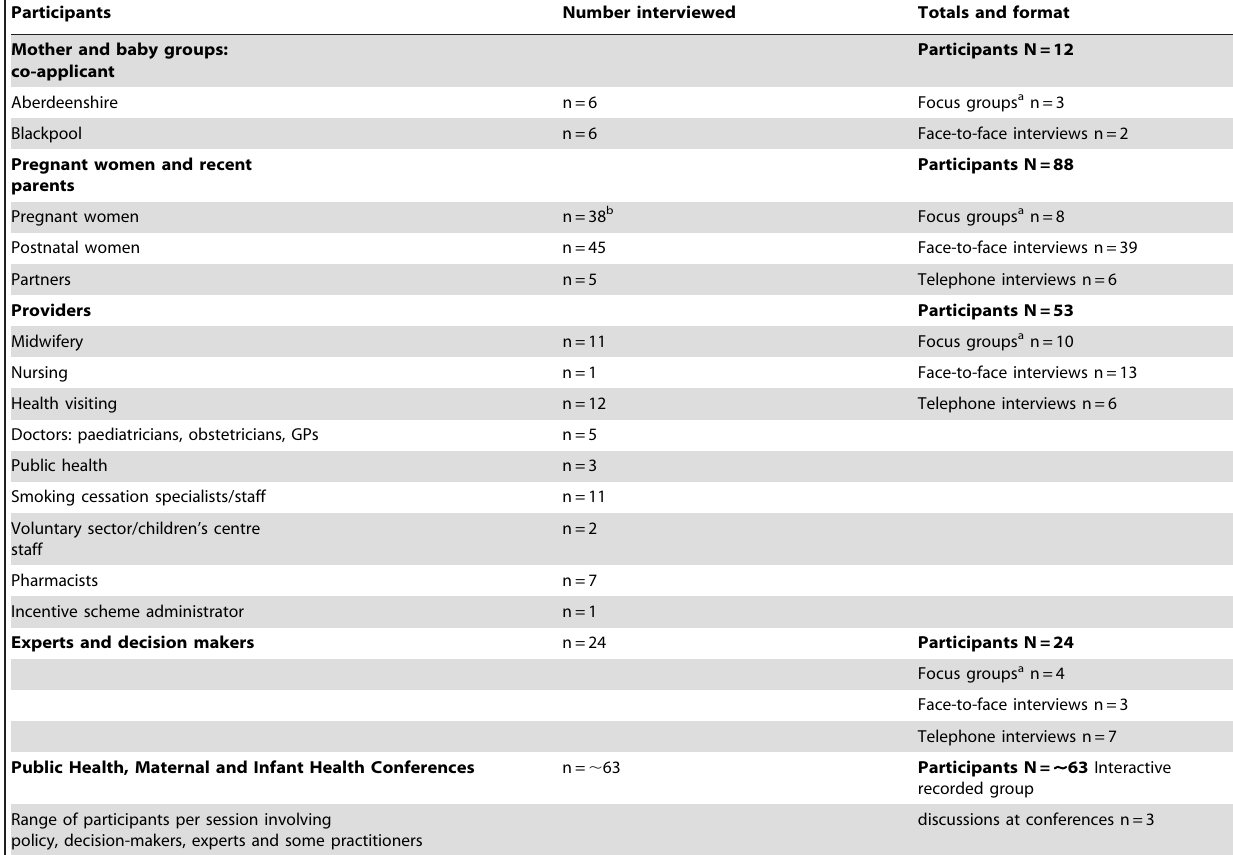
Table 3. Study participants.